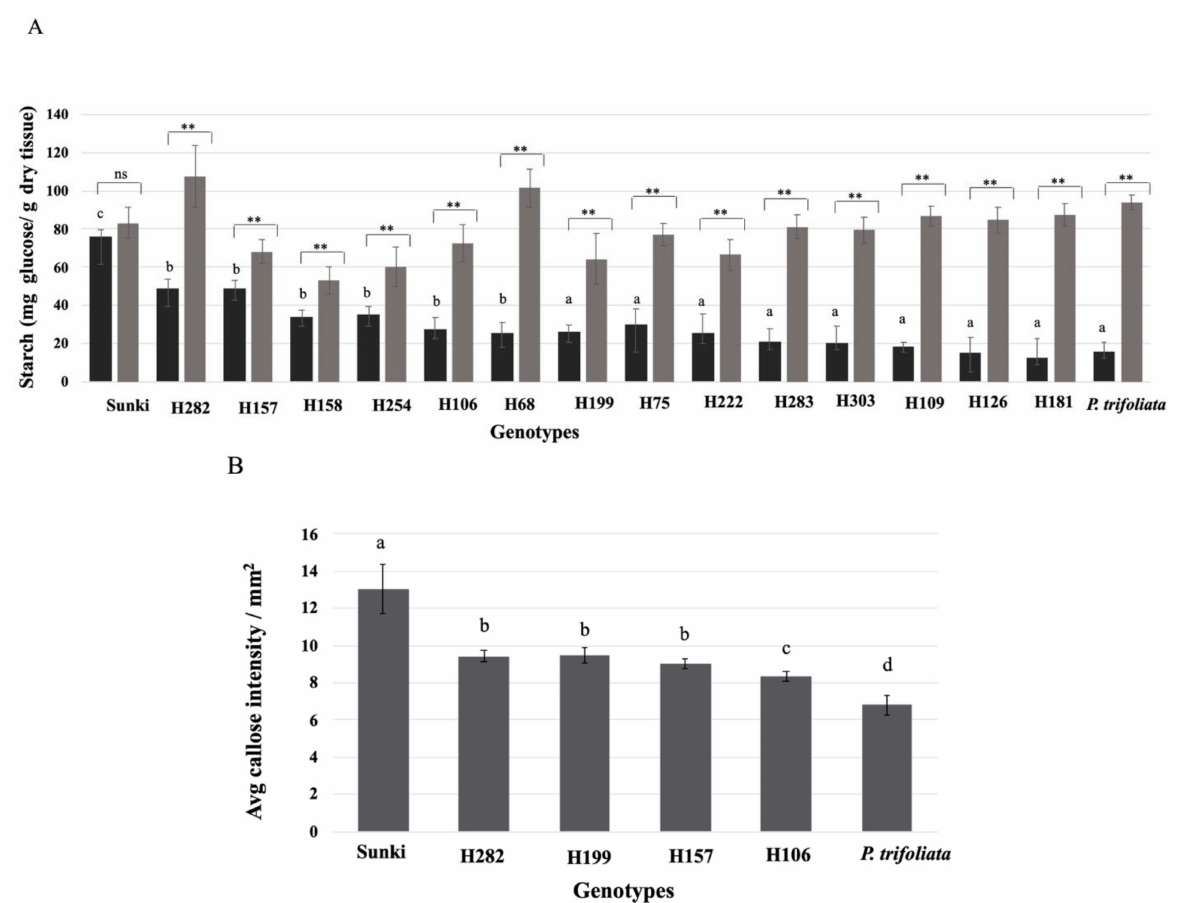
Figure 1. Physiological responses of citrandarins and parent species C. sunki and Poncirus trifoliata to CLas infection. ( A ) Average starch content obtained from four sampling points (90, 180, 270, and 360 days from top-grafting). Vertical bars represent standard deviations of replicates for each genotype across sampling dates. Significant differences (Scott-Knott testing for comparison of the means) among citrandarins are shown by letters. Significant differences ( t -testing for comparison of the means) between hybrids or parents (black bars) and the Valencia HLB-diseased plants (gray bars) are indicated by asterisks (** p < 0.001); NS—no significant. ( B ) Callose quantification in leaf petioles of selected genotypes. Vertical bars represent standard deviations of 10 cross-sections for each genotype sampled 12 months after top-grafting. Significant differences (Scott–Knott testing for comparison of the means, p < 0.05) among citrandarins are shown by